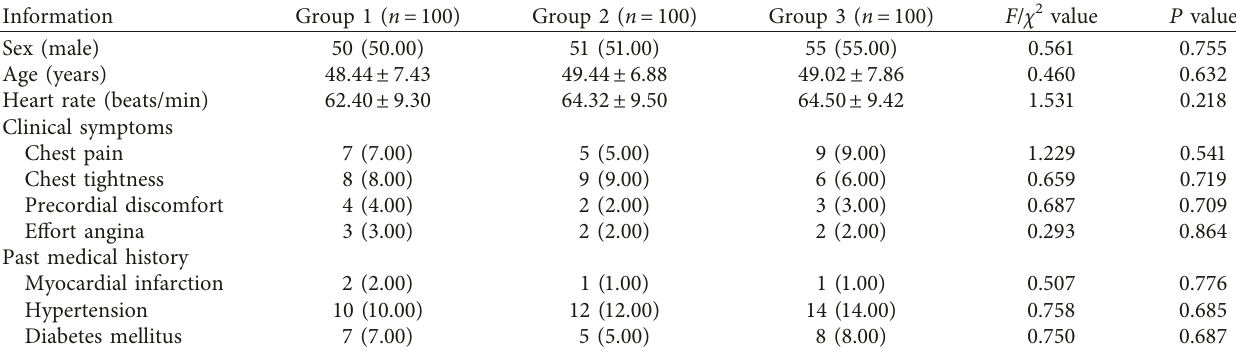
Table 1: Comparison of age, sex, and heart rate among the three groups of patients ( n , %; ( x ± s )). Information